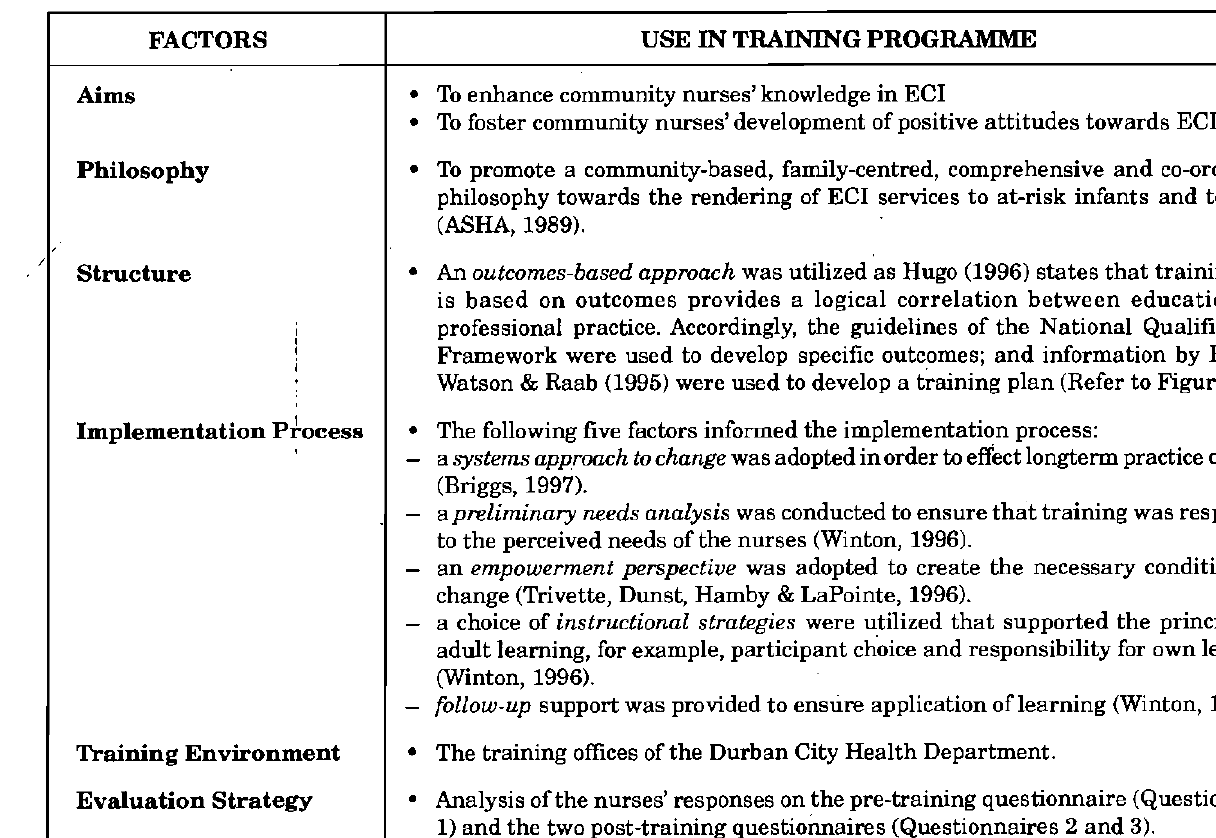
TABLE 2: Development of the training programme